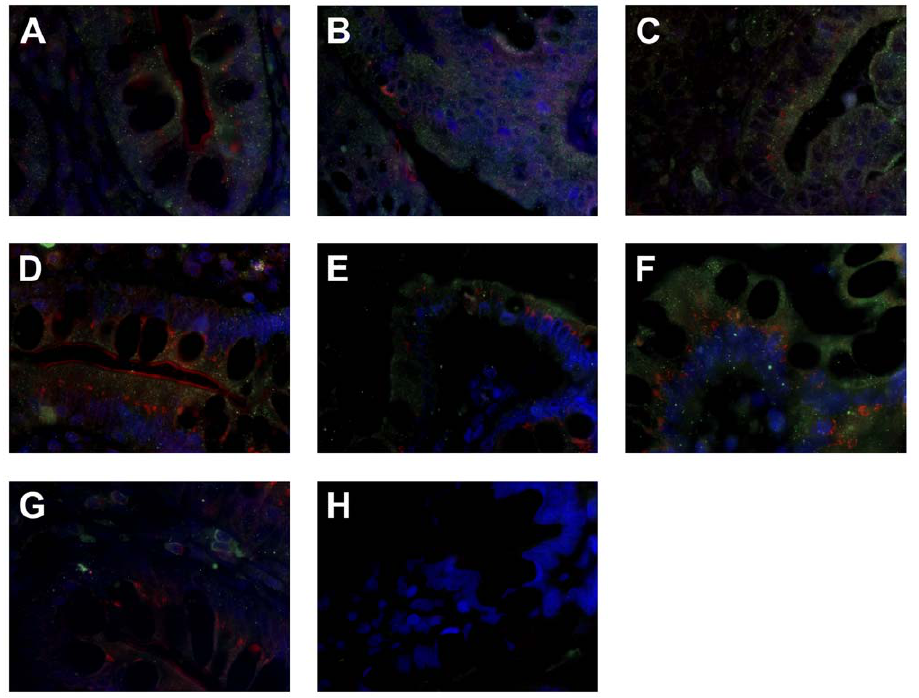
Figure 3. Co-expression of Fc e RI a - and c -chain, but not Fc e RI a - and b -chain is observed in epithelial cells of intestinal tissue. In sections from cancer patient No. 23 Fc e RI c -chain (green) is found to be co-expressed in Fc e RI a (red) positive epithelial cells of (A) the small intestine, as well as in (B) colon tissue and (C) tumor sample. In addition, sections from CD patient No. 8 are double-positive for Fc e RI a - and c -chain in (D) the small intestinal, (E) colon and in (F) lesional tissue. (G) Only in the subepithelial tissue Fc e RI b -chain (green) positive cells are detected as shown here in the crypts of small intestinal tissue. (H) Negative control with mouse IgG2b and goat IgG isotype control antibodies. The blue fluorescence DAPI staining indicates the nuclei. Original magnification 6 64. doi:10.1371/journal.pone.0009023.g003 PLoS ONE |